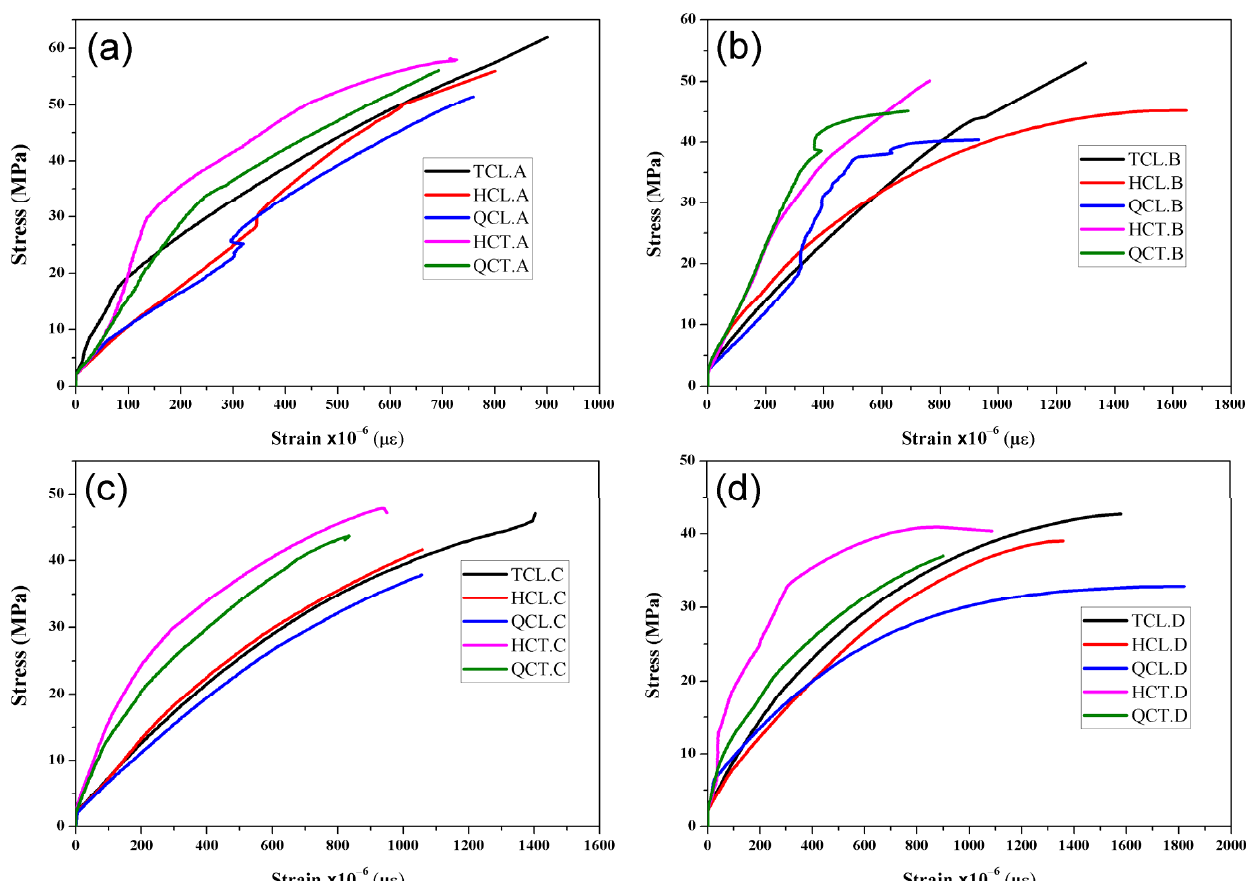
Figure 4. Stress–strain curves under monotonic load: ( a ) concrete made with 0.33 W/C; ( b ) concrete made with 0.36 W/C; ( c ) concrete made with 0.401 W/C; and ( d ) concrete made with 0.522 W/C. Table 6. Specimens’ experimental results of the compressive strength.